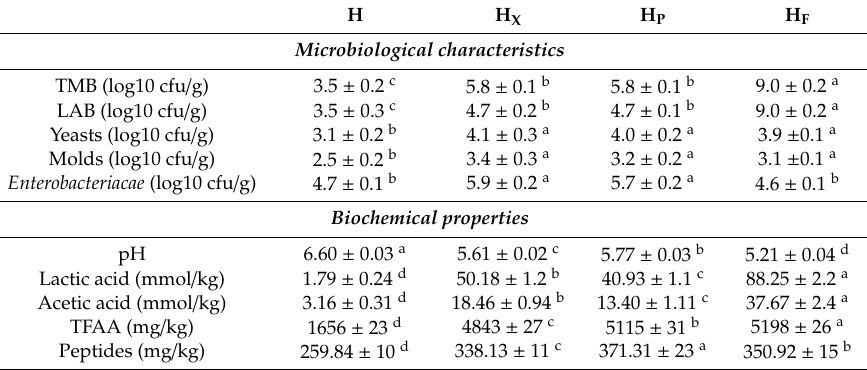
Table 1. Microbiological and biochemical characteristics of raw and bioprocessed hemp. H, mixture of hemp flour and water (ratio 1:1); H X , mixture of hemp flour and water (ratio 1:1) treated with xylanase Depol 761P (1% wt / wt of fiber); H P , mixture of hemp flour and water (ratio 1:1) treated with protease Veron PS (2.5% wt / wt of protein); H F , mixture of hemp flour and water (ratio 1:1) fermented by Lactiplantibacillus plantarum 18S9 and Leuconostoc mesenteroides 12MM1 (ratio 1:1, final cell density of circa 7 log10cfu / g). All treated samples were incubated at 30 ◦ C for 24 h. H H X H P H F